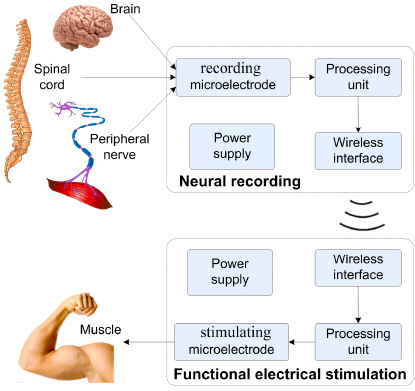
Figure 1. Structural illustration of implantable artificial nerve system for paralysis rehabilitation.